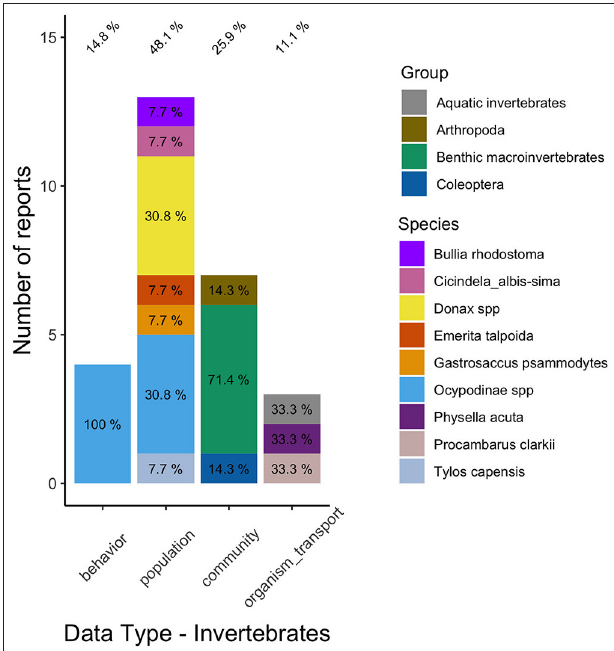
FIGURE 6 | Number of reports ( n = 27) that accessed the impacts of off-road vehicle (ORV) use on invertebrates across the type of ecological data collected (behavior, community-level, population-level, or organism transport). Results are categorized by the organism or group of organisms that were